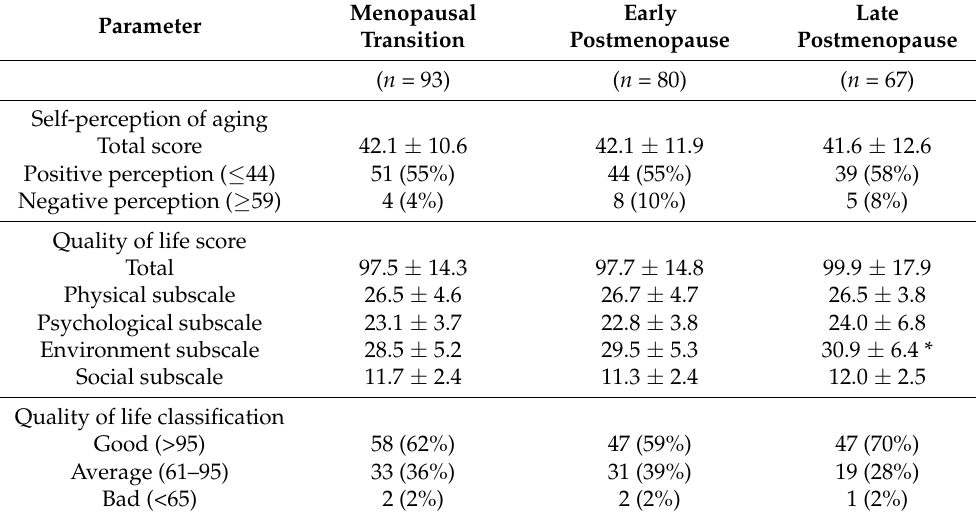
Table 2. Self-perception of aging and the quality of life by study group.